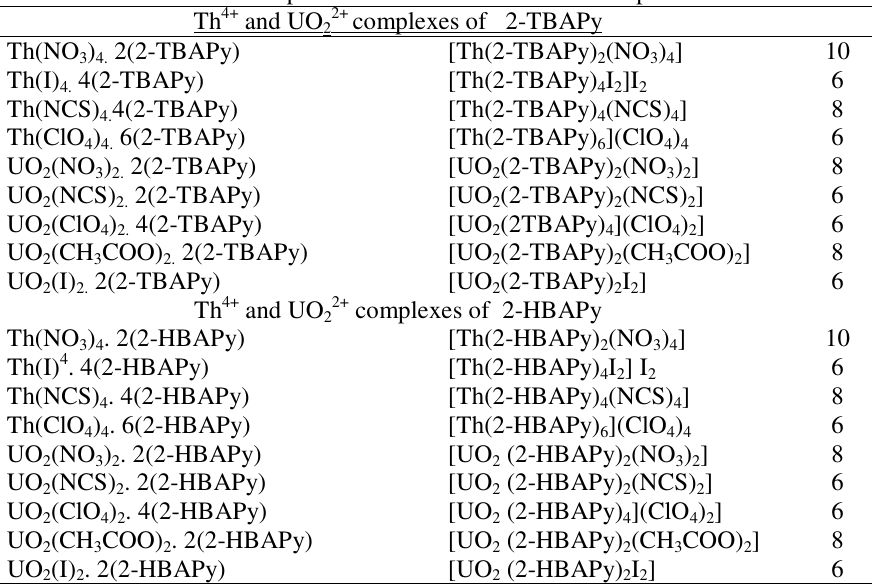
Table 9. Proposed coordination number of